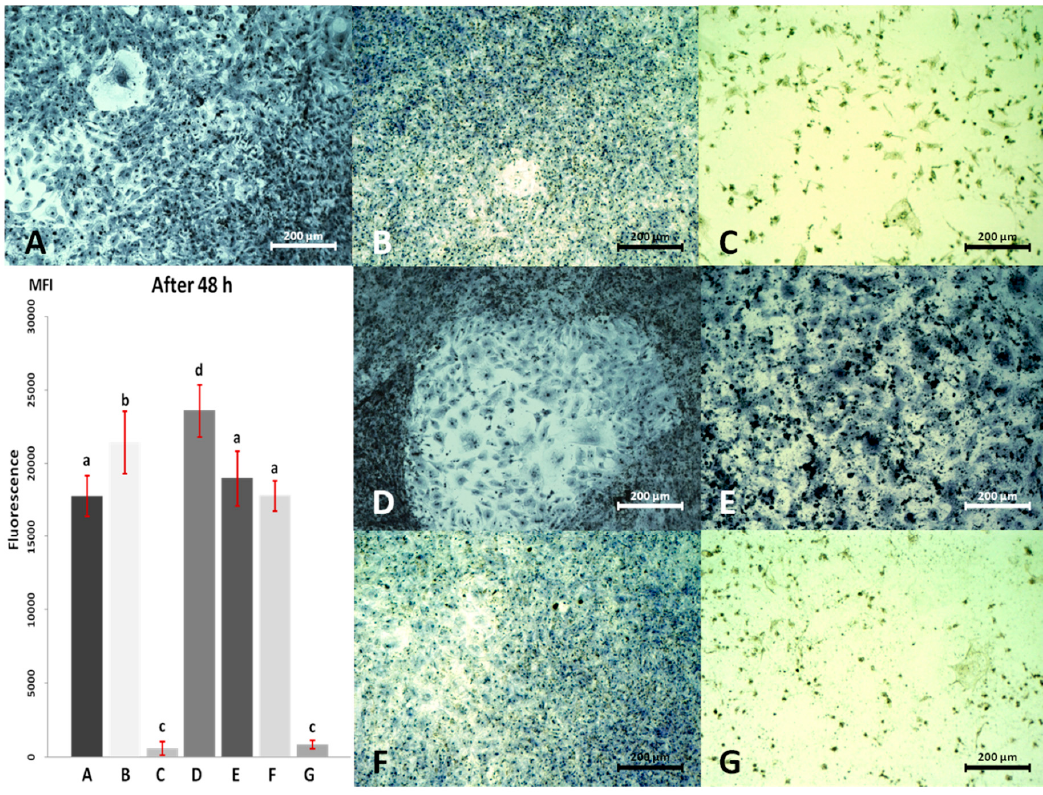
Figure 6. Cardiac progenitor cell morphology and viability after 48 h of culture with AgNP and HNC; ( A ) control culture; ( B ) culture with 2 μ g/mL AgNP; ( C ) culture with 10 μ g/mL AgNP; ( D ) culture with 0.4 μ g/mL HNC; ( E ) culture with 2 μ g/mL HNC; ( F ) culture with 2 μ g/mL AgNP and 0.4 μ g/mL HNC; ( G ) culture with 10 μ g/mL AgNP and 2 μ g/mL HNC. (A–G) Series of viability in individual experimental groups measured as fluorescence. (a–d) Statistically significant differences ( p ≤ 0.05). Magnification 100×. Scale bars 200 μ m. MFI—mean fluorescence intensity.